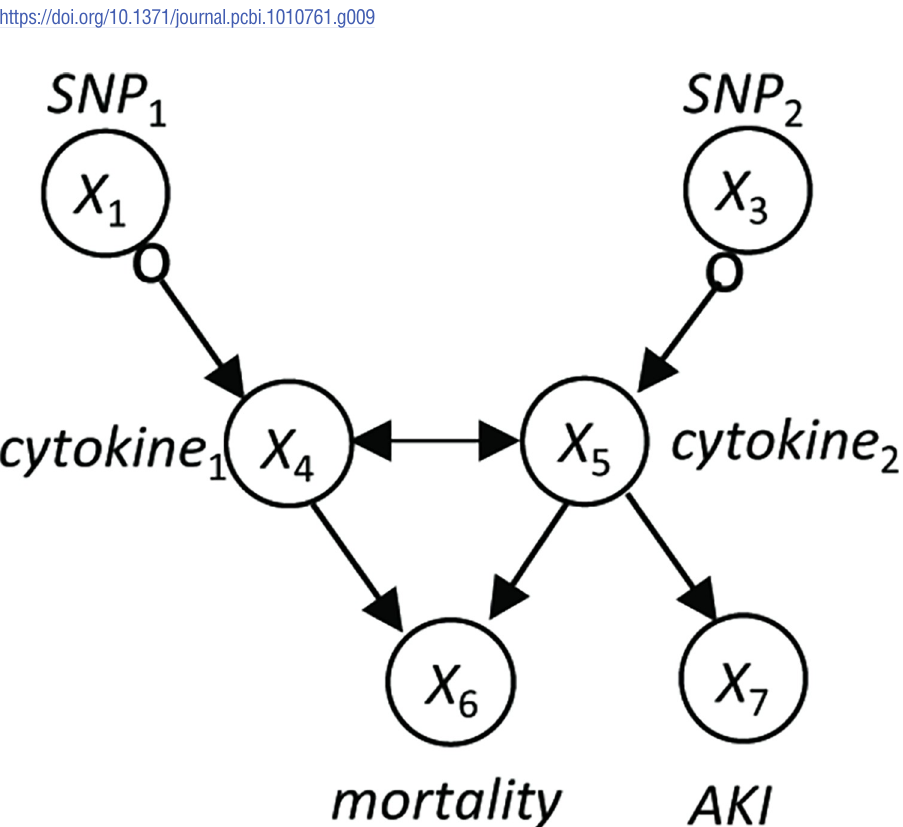
Fig 10. A PAG representing the four MAGs shown in Fig 9.